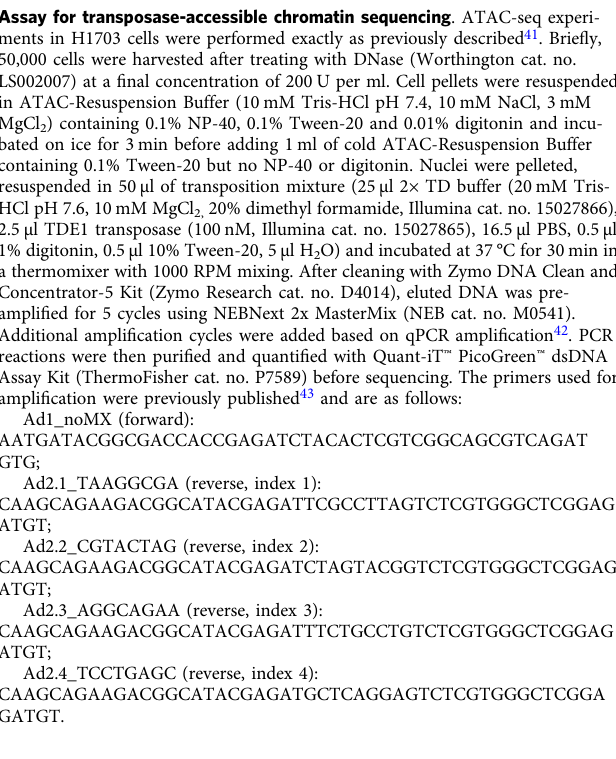
Fig. 5 SMARCA4/2 regulate CCND1 via controlling chromatin accessibility and upregulating JUN . a Assay for transposase-accessible chromatin sequencing (ATAC-seq) and chromatin immunoprecipitation sequencing (ChIP-seq) data in vicinity of the CCND1 locus indicate enhanced chromatin accessibility upon SMARCA4/2 restoration. Note SMARCA4 at CCND1 promoter and formation of new putative enhancer ~50 kb upstream of CCND1 promoter. All data were generated in H1703 cells before and after restoration of SMARCA4 or SMARCA2, except the publicly available SMARCA4 ChIP data in H1299 cells expressing doxycycline (Dox)-inducible SMARCA4 34 . Track height is normalized to relative number of mapped reads. b Zoomed-in view of the putative CCND1 enhancer region. Shown are ATAC-seq peaks in H1703 cells before and after SMARCA4/2 restoration and the publicly available c-Fos/c-Jun ChIP data of endothelial cell line, human umbilical vein endothelial cell (HUVEC) (GSM935585, GSM935278). Location of canonical adaptor protein-1 (AP-1) motifs are indicated. c ATAC and ChIP-seq data in vicinity of JUN locus as described in a . Note SMARCA4 at JUN promoter and extensive opening of nearby putative enhancers. d – i Restoration of SMARCA4 in H1703 ( d , e ) and H1299 ( f , g ) or SMARCA2 restoration in H1703 ( h , i ) cells upregulate c-Jun messenger RNA (mRNA) ( d , f , h ) and protein ( e , g , i ). j , k Knockdown of JUN partially abrogated SMARCA4-mediated induction of cyclin D1 mRNA ( j ) and protein ( k ) expression in H1703 cells. l Proposed model showing that SMARCA4 directly regulates CCND1 and also upregulates JUN which